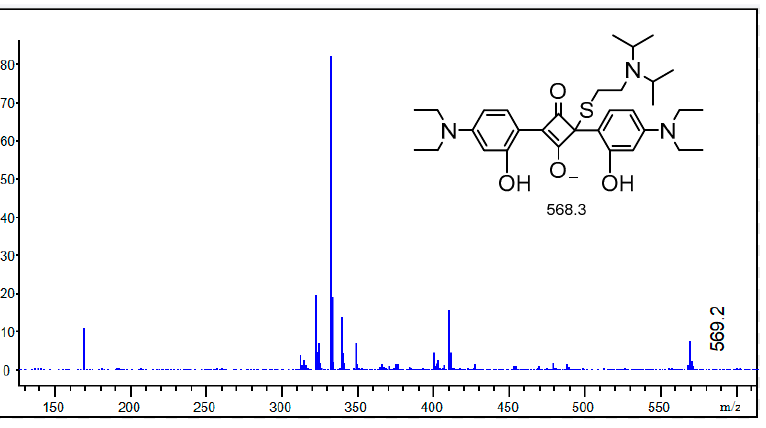
Figure 8. MS of the VX thiol fraction in the mixture of the SP with TBAF and VX.